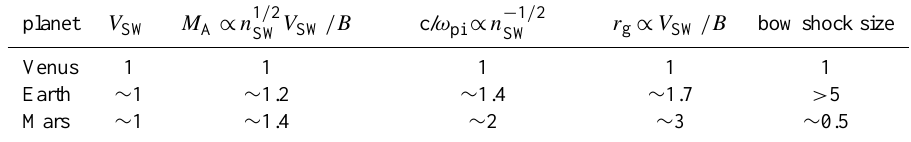
Table 1. Parameters of Earth and Mars as compared to Venus. planet V